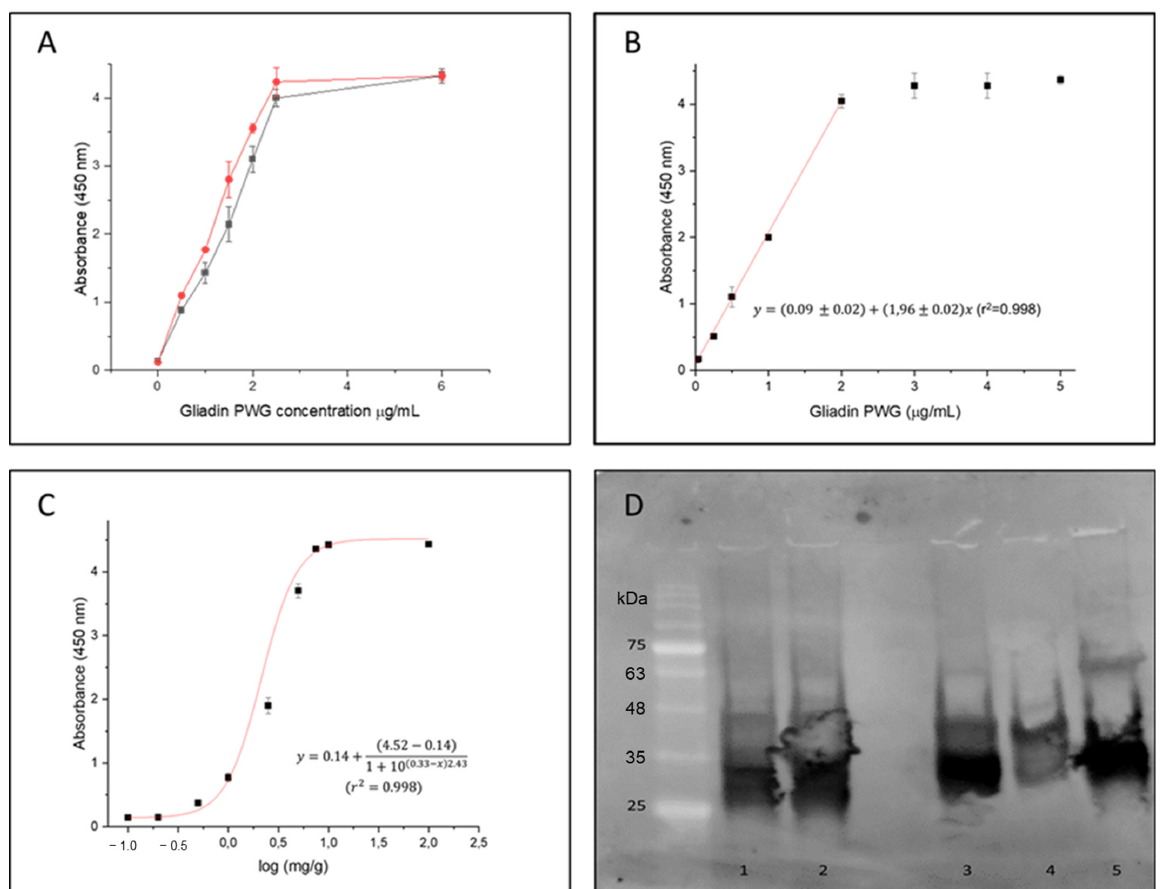
Figure 4. Characterization of phage-Fab8E-4. ( A ) Comparative dose-response curve obtained against gliadin-PWG dilutions (0–6 µg/mL) by means of dAb-8E (grey) and Fab8E-4 (red) antibody fragments attached to VSCM13 helper phage (4 × 10 11 pfu/well). ( B ) Linear regression obtained against gliadin dilutions (0.01–2 µg/mL) by means of Fab8E-4 in order to determinate the LOD and LOQ. ( C ) Representative dose-response curve from the analysis of experimental rice–based binary mixtures with increasing presence of a proportional mixture of wheat, barley and rye in the range of 0.1 to 100 mg/g. Origin 8.0 software was employed to plot and analyze the experimental data. Mean values of three independent determinations and standard derivation of each data set are shown. ( D ) Western blot analysis of gliadin and flour proteins incubated with phage-Fab8E-4 as primary antibody. Lane 1 (1 mg per well) and Lane 2 (2 mg per well): gliadin (Merck©, CAS #9007–90-3) dissolved in 50% isopropanol-water; Isopropanol extractions of cereal flours: Lane 3: wheat; Lane 4: barley; Lane 5: